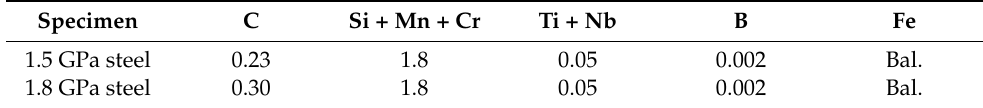
Table 1. Chemical compositions of studied steels. Specimen